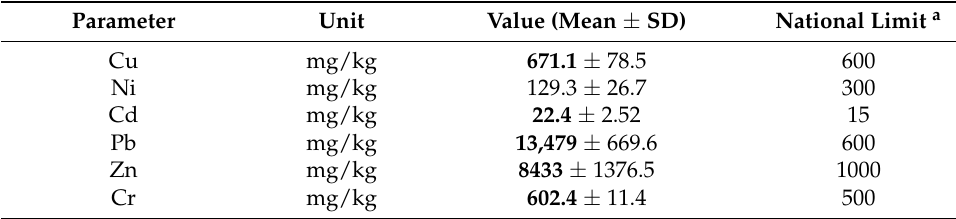
Figure 1. Localization of the study site in Northeastern Poland. Table 1. Total PTEs’ concentration in the soil used in the experiment.